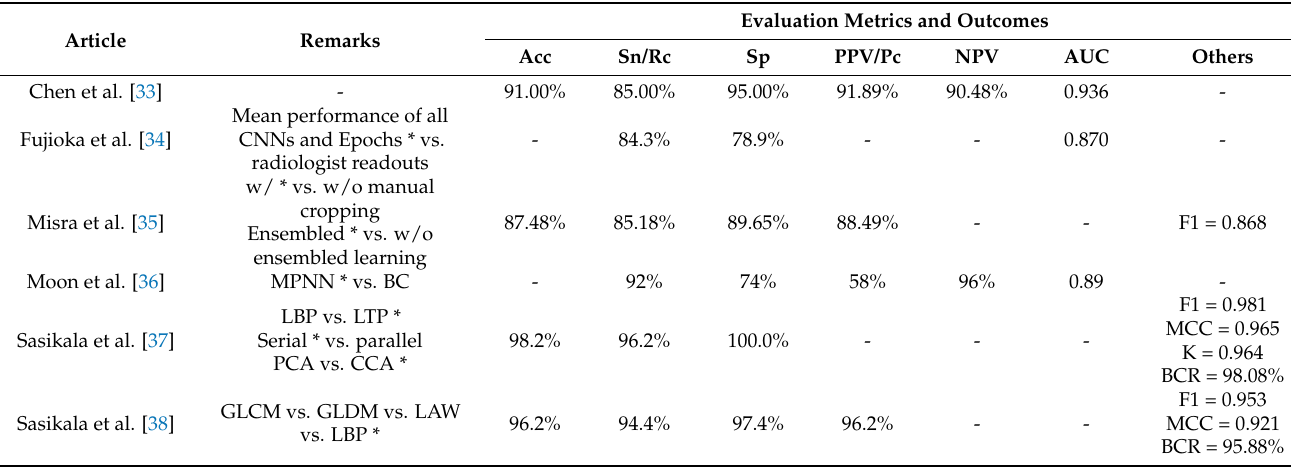
Table 4. Evaluation metric and outcome